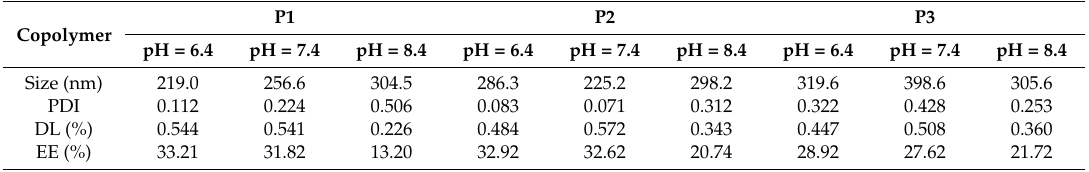
Table 5. Particle size and the DOX-loading efficiency for the drug-loaded copolymer micelles.